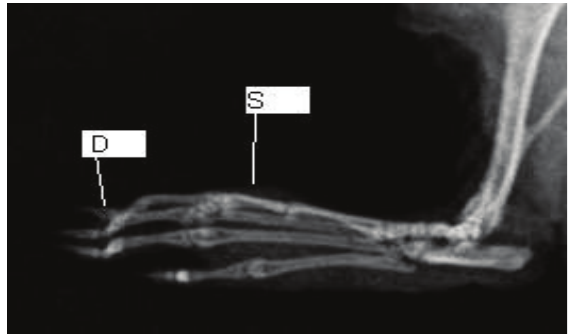
Fig-10: Therapeutic Group 10 Anthraquinone 500mg/kg treated rats showing significant improvement of joint swelling by less soft tissue swelling.